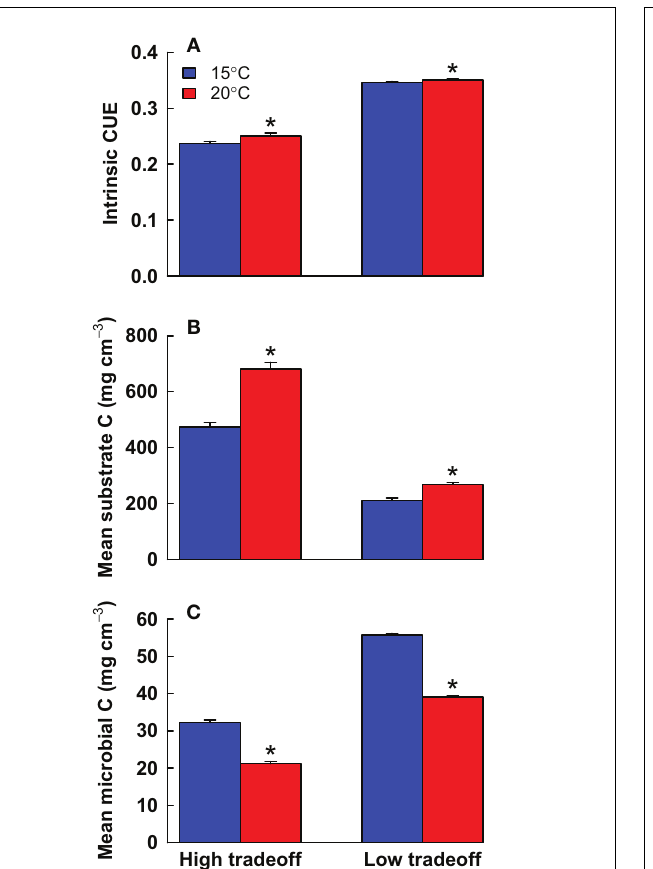
FIGURE 3 | Relationship between change in intrinsic carbon use efficiency (CUE) with 5 ◦ C warming (20 ◦ C minus 15 ◦ C) and change in (A) microbial biomass carbon or (B) substrate carbon. Linear regression statistics are given for the combined high and low tradeoff scenarios in the DEMENT